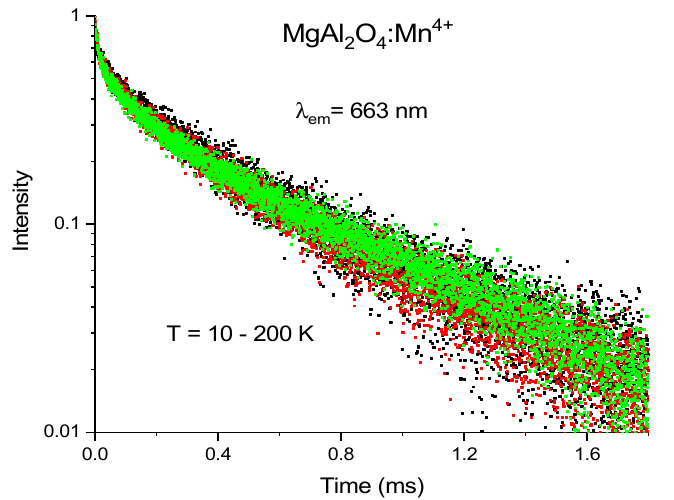
Figure 4. Normalized decay curves of red ( λ em = 663 nm) luminescence recorded from sample I, MgAl 2 O 4 doped with 0.2 mol% MnO 2 , at T from 10 K to 200 K. On the other hand, in MnO 2 doped MgAl 2 O 4 samples subjected to the high tem- perature annealing only (temperature steps at 1000, 1200, and 1300 ◦ C) but without the